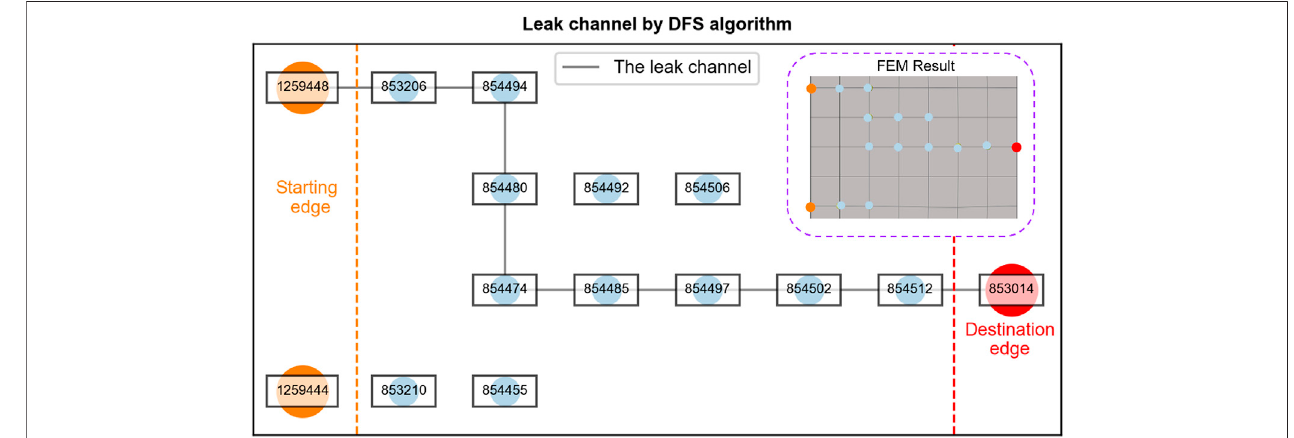
FIGURE 9 | Leak path detection.